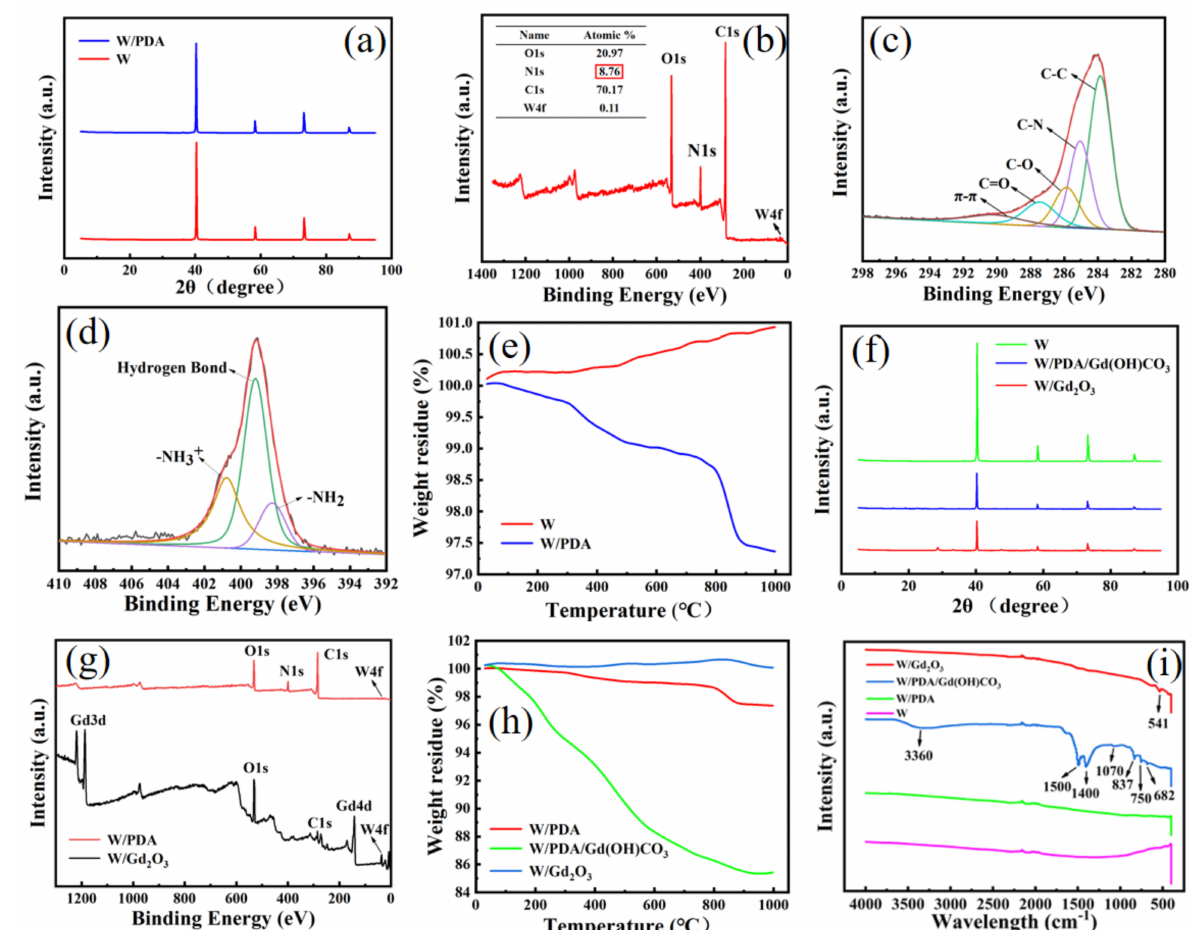
Figure 3. ( a ) XRD pattern of W and W/PDA; ( b ) XPS broad spectrum of W/PDA; ( c ) XPS peak fitting pattern of C1s of W/PDA; ( d ) XPS peak fitting pattern of N1s of W/PDA; ( e ) TG curve of W and W/PDA; ( f ) XRD pattern of W, W/PDA/Gd(OH)CO 3 and W/Gd 2 O 3 ; ( g ) XPS spectra of W/PDA and W/Gd 2 O 3 ; ( h ) TG curves of W/PDA, W/PDA/Gd(OH)CO 3 , and W/Gd 2 O 3 ; and ( i ) FTIR spectra of W, W/PDA, W/PDA/Gd(OH)CO 3 , and W/Gd 2 O 3